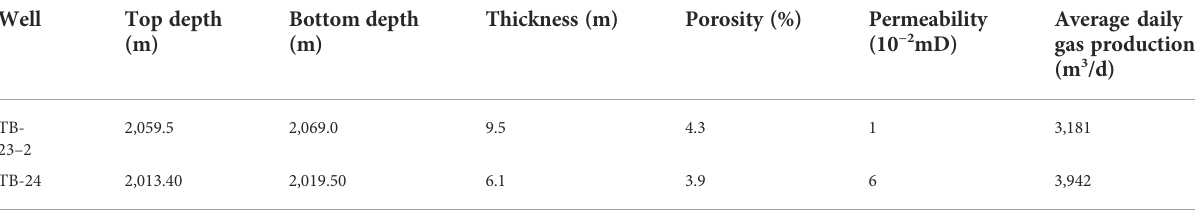
TABLE 2 Logging Interpretation results for coal seams 8+9# and average daily gas production in wells LXX 23 – 2 and LXX-24.